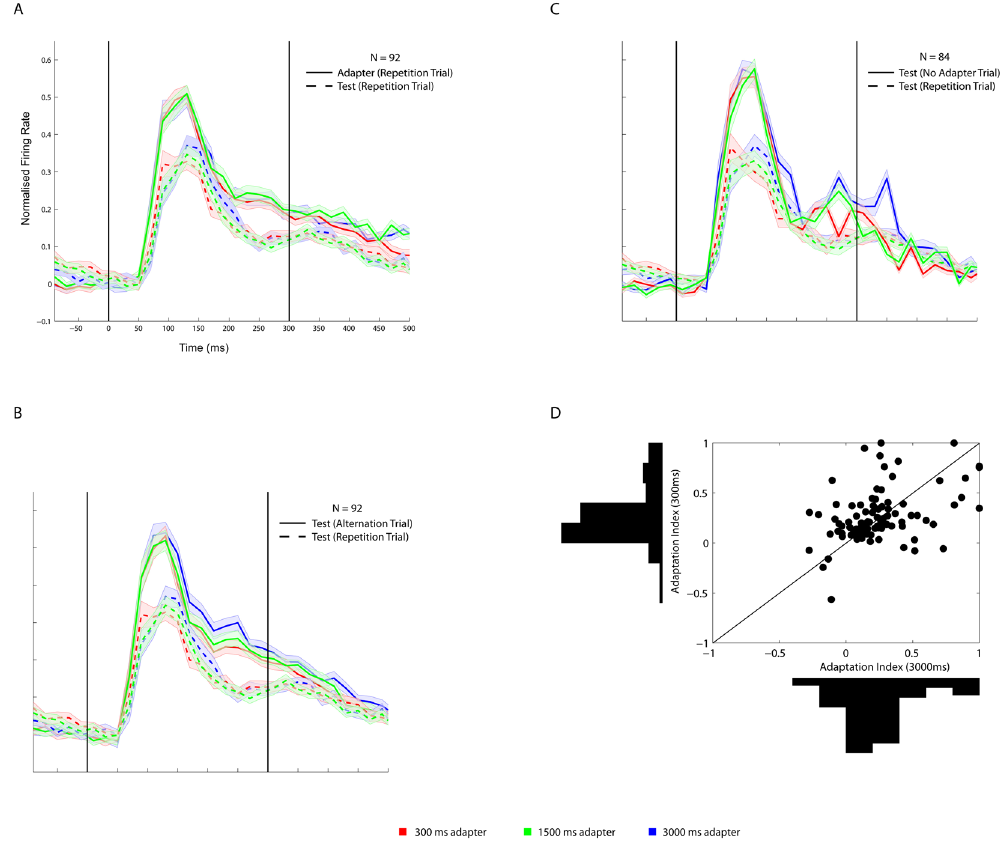
Figure 2. Responses to adapter and test stimuli as a function of adapter duration. ( A ) Normalized net firing rate to adapter and test stimuli in repetition trials for the 3 adapter durations. 0 corresponds to the onset of the adapter or test stimulus. The two vertical lines indicate the duration of the test stimulus and the adapter in the 300 ms duration condition. For the longer adapter durations, we show only the responses for the initial 500 ms of the stimulus presentation. ( B ) Normalized net firing rate to test stimuli in repetition and alternation trials for the 3 adapter duration conditions. Same neurons as in A. Same conventions as in A. ( C ) Normalized net responses to the same test stimuli without adapter (no adapter trial) or an adapter in repetition trials. The 84 neurons are a subsample of the 92 neurons in A and B. Same conventions as in A. Binwidth is 20 ms and no smoothing was applied. Shaded bands correspond to standard error of the mean. ( D ) Scatter plot and marginal distributions of adaptation contrast indices for 3000 ms (x-axis) and 300 ms (y-axis) adapter durations. The diagonal (equal x and y values) is indicated by a black